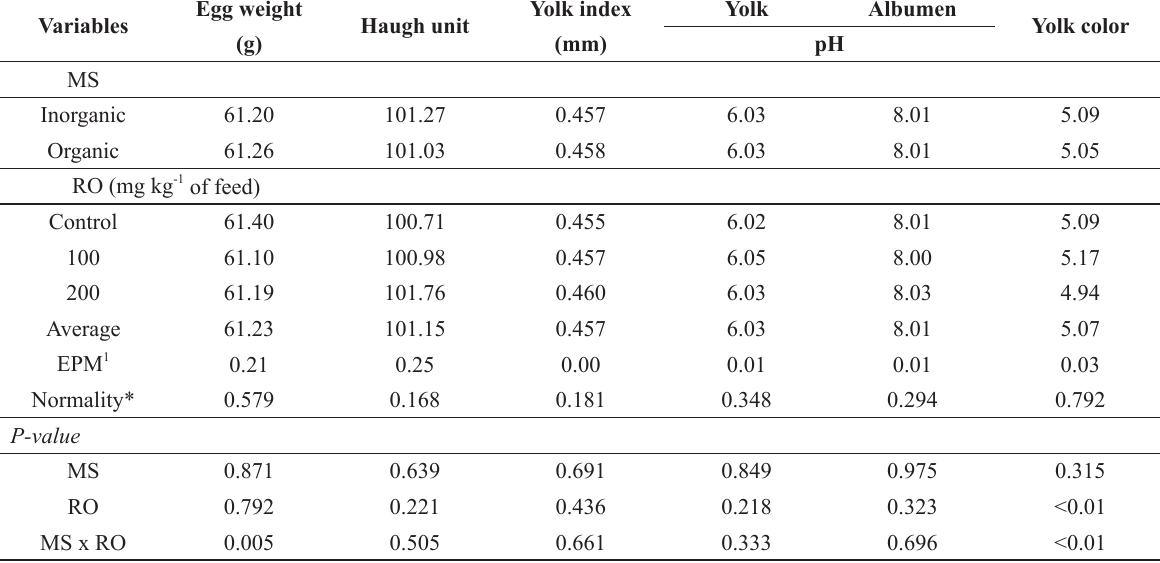
Quality of eggs from red layers fed different mineral sources (MS) and rosemary oil levels (RO).